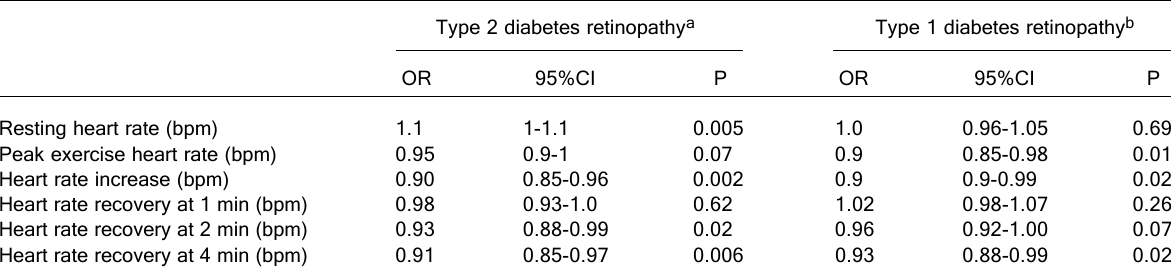
Table 3. Multivariate analysis of heart rate at stress test and the presence of diabetic retinopathy in type 2 and type 1 diabetes.